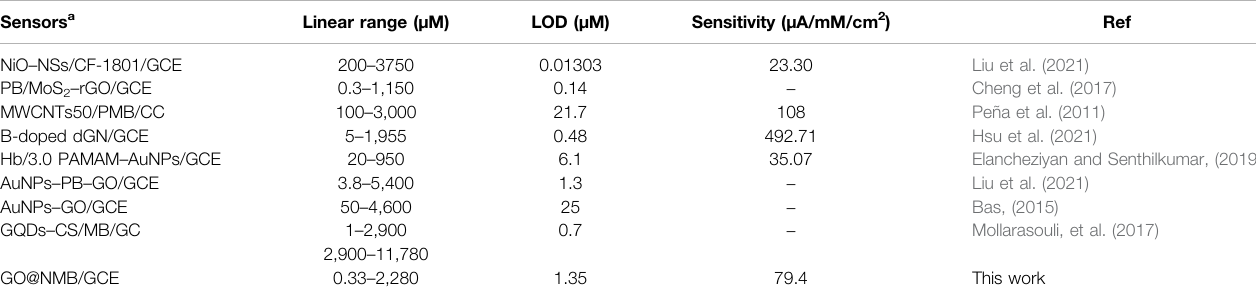
TABLE 1 | Comparison of the presented sensor for electrochemical determination of hydrogen peroxide (H 2 O 2 ) with other reported sensors. Sensors